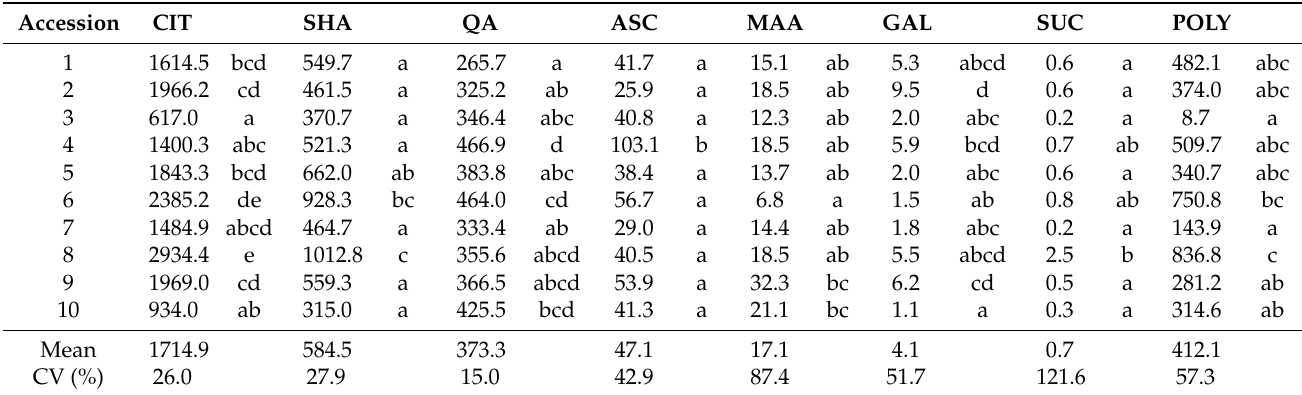
Table 3. Means (fruits quintuplicate for each accession) of organic acids and related compounds determined by NMR and expressed in mg 100 g − 1 .